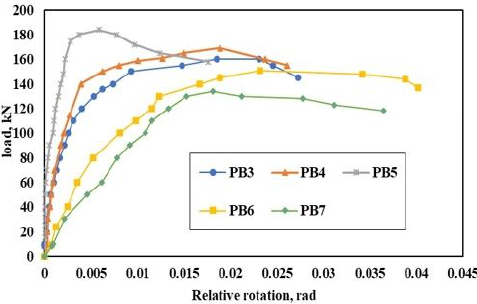
Figure 12: Load-relative rotation test experimental results for the mechanical and chemical connecting groups specimens